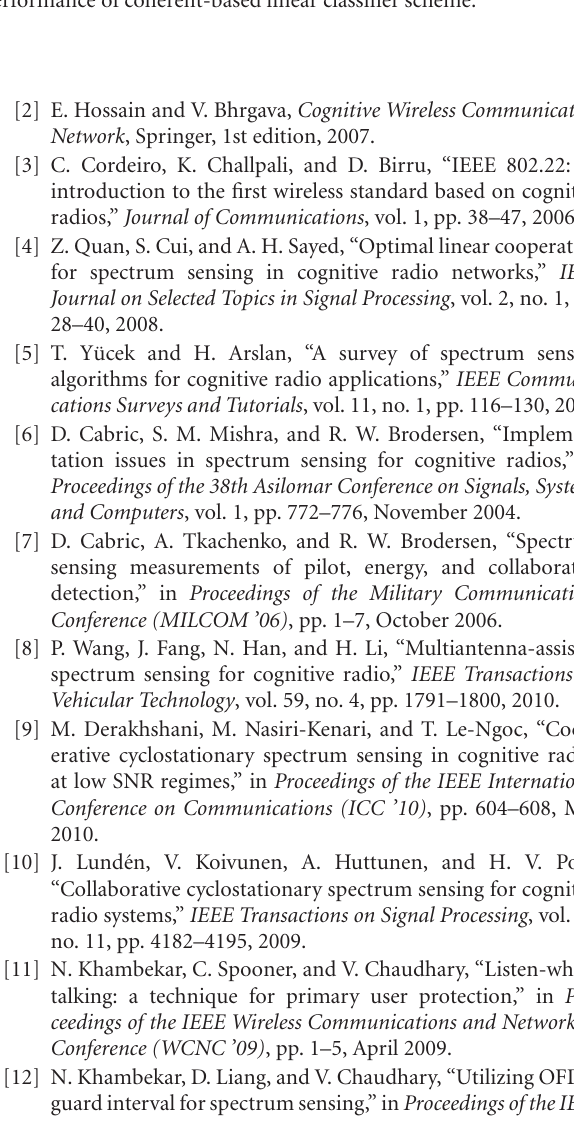
Figure 12: Impact of the preamble length on detection performance of coherent-based linear classifier